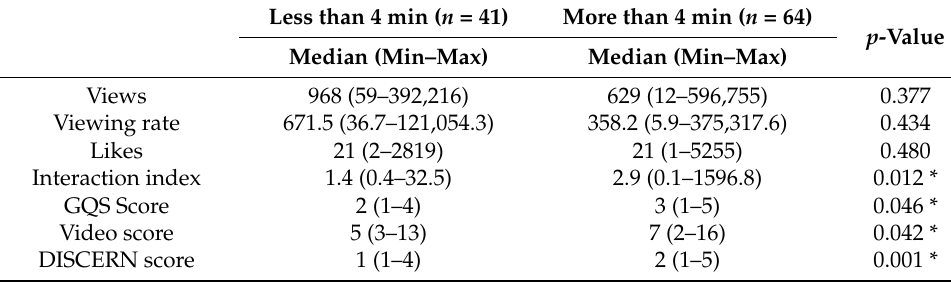
Table 6. Comparison of video variables based on duration.